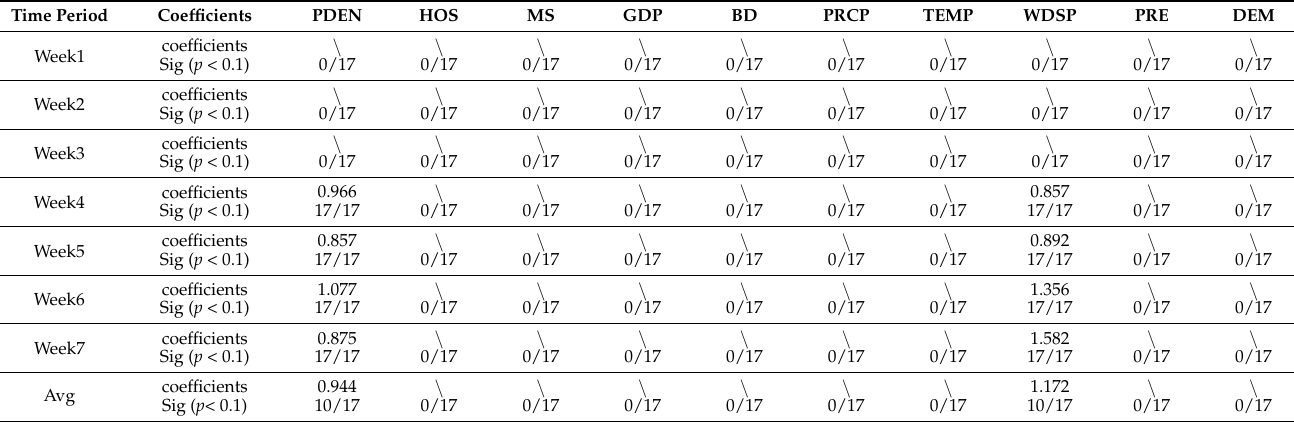
Table 7. ESF-SVC model coefficients in Hubei